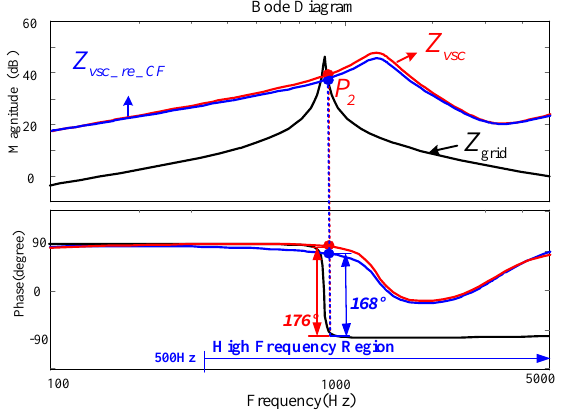
Figure 5. HFR damping controller without re-designing parameters for 1 kW VSC system when filter inductance changes.